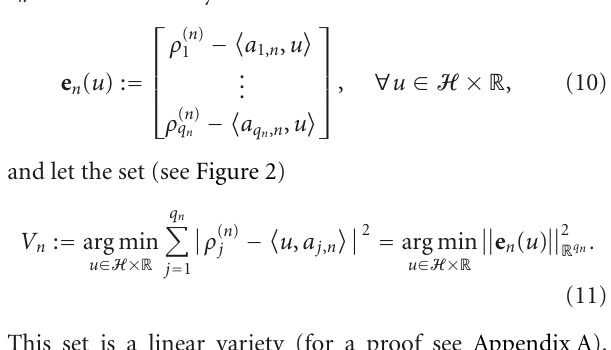
Figure 2: For simplicity, we assume that at some time instant n ∈ = 2. This figure illustrates the closed Z ≥ 0 , the cardinality card( J n ) } 2 and their boundaries, that is, the hyperplanes half-spaces { Π + j , n j = 1 (cid:20) 2 { Π } 2 . In the case where Π j , n / = ∅ , the defined in (11) j , n j = 1 j = 1 (cid:20) 2 linear variety becomes V n = Π j , n , which is a subset of j = 1 The kernel APA aims at finding a point in the linear variety V n , while Algorithm 1 and the APSM consider the more general setting (cid:20) 2 . Due to the range of the extrapolation of finding a point in Π + j , n j = 1 parameter μ n ∈ [0,2 M n ] and M n ≥ 1, the APSM can rapidly furnish solutions close to the large intersection of the closed half- spaces (see also Figure 6), without su ff ering from instabilities in the calculation of a Moore-Penrose pseudoinverse matrix necessary for finding the projection P V n